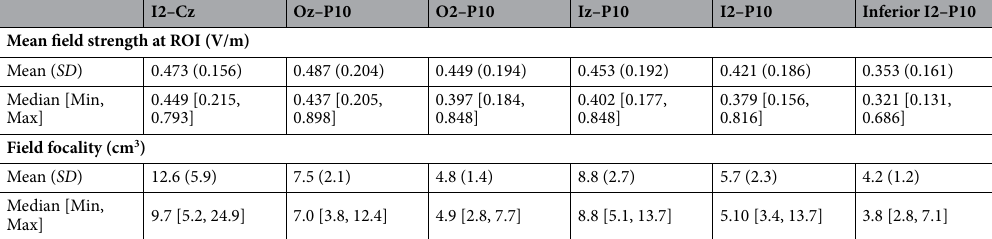
Table 2. Mean field strength at the ROI and field focality for each of the six tested alternative electrode montages.